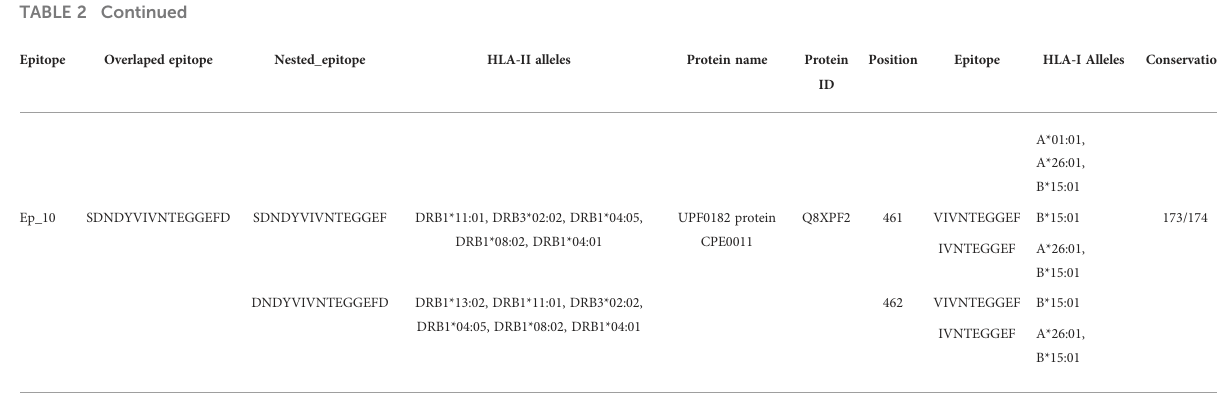
Epitopes “ 2 ” and “ 7 ” (with asterisk) were not included in the fi nal design. Conservation is represented as the number of sequences where epitope is conserved over the total number of sequences